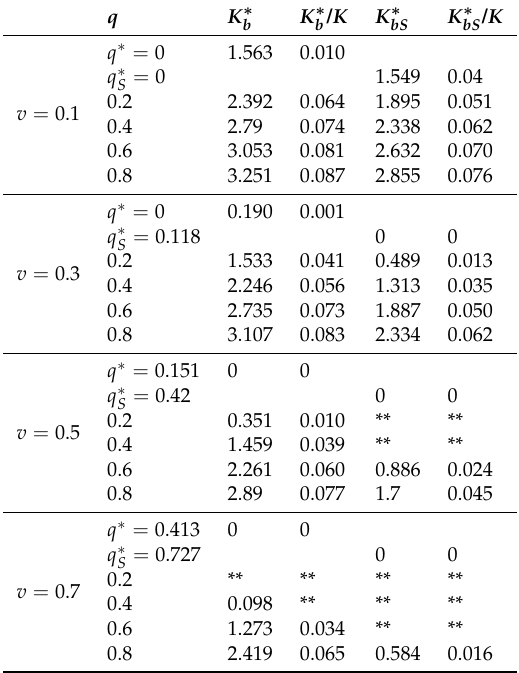
Table 2. Optimal security investment and its allocation with propagation probability q and intrinsic vulnerability v .